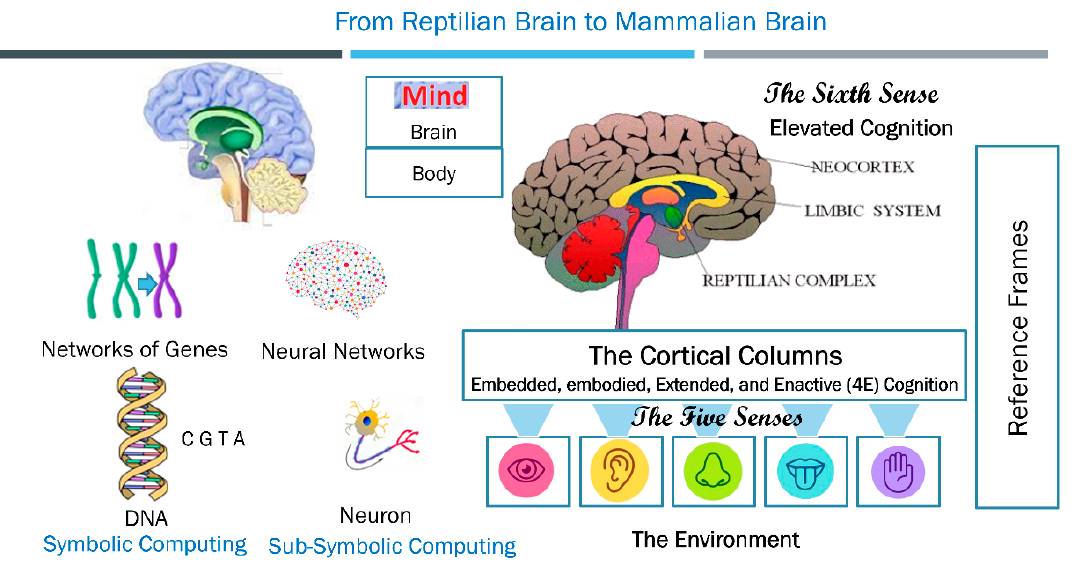
Figure 1. Two views of the mind, brain, and body